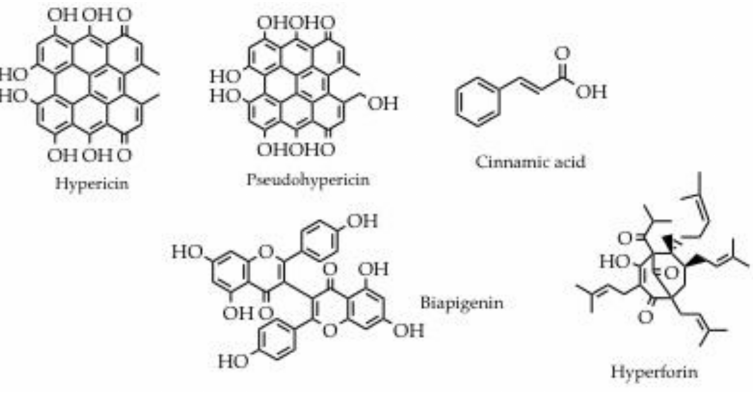
Figure 6. Main secondary metabolites produced by Hypericum perforatum